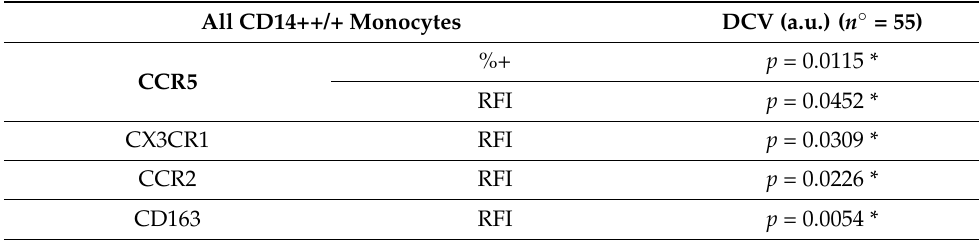
Table 3. Significantly positive association, at multiple regression analysis, between blood CD14++/+ monocyte surface markers and DCV.